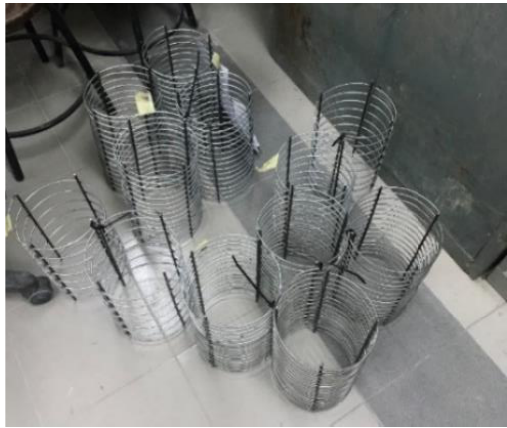
Figure 2. Confining hoop reinforcements.